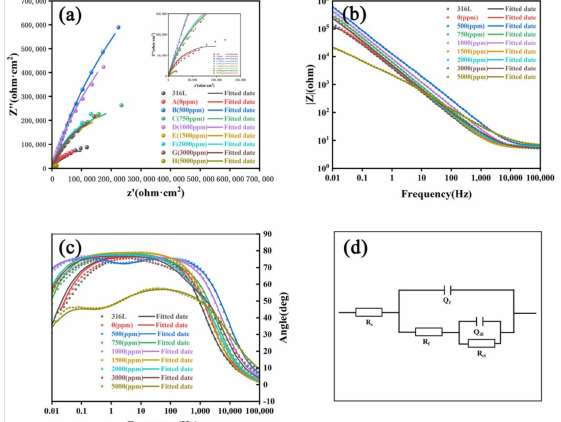
Figure 10. Impedance responses of sintered 316 L stainless steel and heat-treated novel nitrogen-free austenitic stainless steel samples with the addition of different concentrations of graphite. ( a ) Nyquist plot. ( b , c ) Bode plots. ( d ) Equivalent electrical circuit used in the ZSimpWin